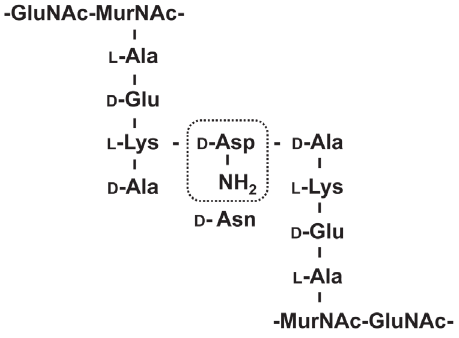
Figure 5. Schematic representation of disaccharide tetrapep- tide with crossbridge in peptidoglycan of L.casei . GluNAc: N - acetyl glucosamine, MurNAc: N -acetyl muramic acid, L-Ala: L-alanine, D- Glu: D-glutamic acid, L-Lys: L-lysine, D-Ala: D-alanine, D-Asp: D-aspartic acid, D-Asn: D-asparagine.